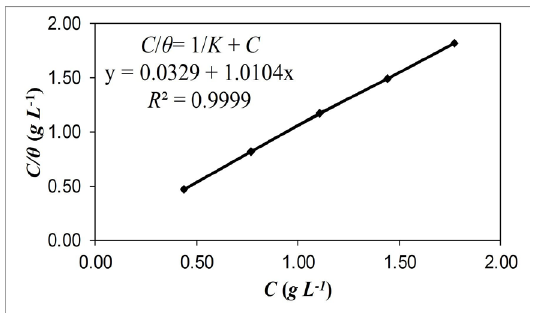
Figure 9. Langmuir adsorption isotherm for SAE 1008 carbon steel for different concentrations of cocoa bean shell powder in 0.5 mol L -1 HCl.